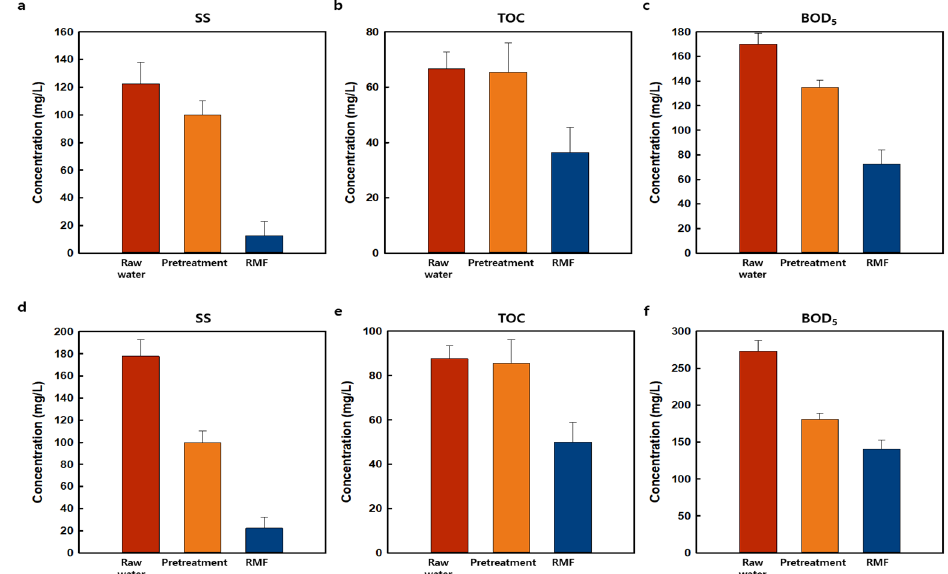
Figure 3. Removal of contaminants in combined sewer overflows ( a ) SS (Suspended Solids), ( b ) TOC (Total Organic Carbon), ( c ) BOD 5 (Biochemical Oxygen Demand) in dry weather condition, ( d ) SS in rainy weather condition, ( e ) TOC in rainy weather condition, and ( f ) BOD 5 in rainy weather condition. Operating condition: Initial velocity = 20.0 m 3 /h, temperature = 23 °C, and raining intensity = 5 mm/h.